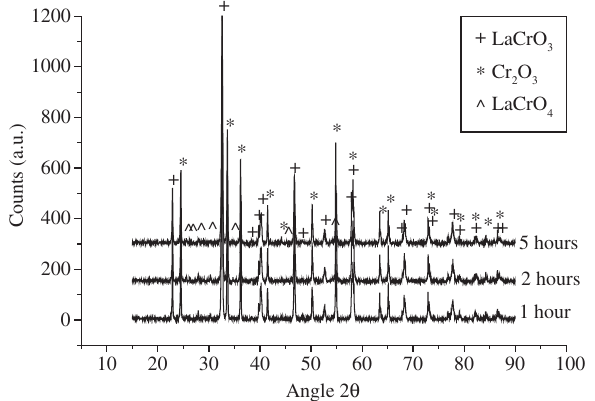
O and La O powder mixture 2 3 2 3